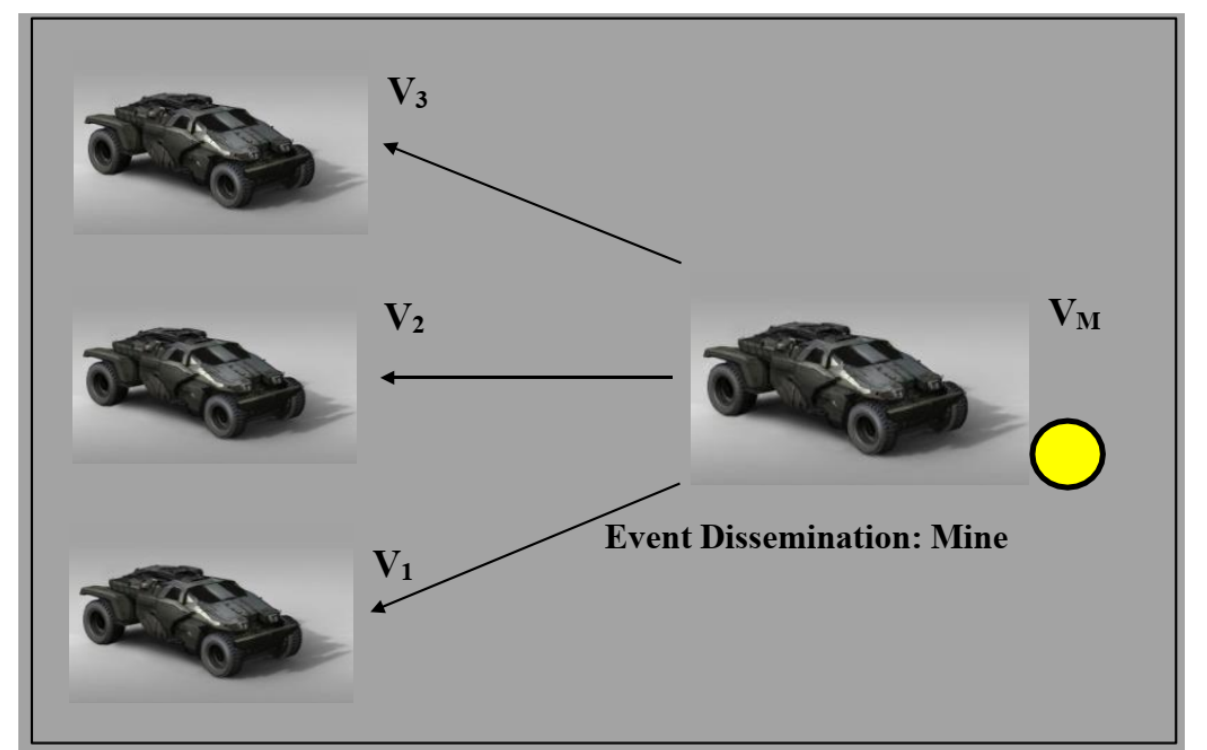
Figure 1. Mine detection and message dissemination to incoming UGVs .